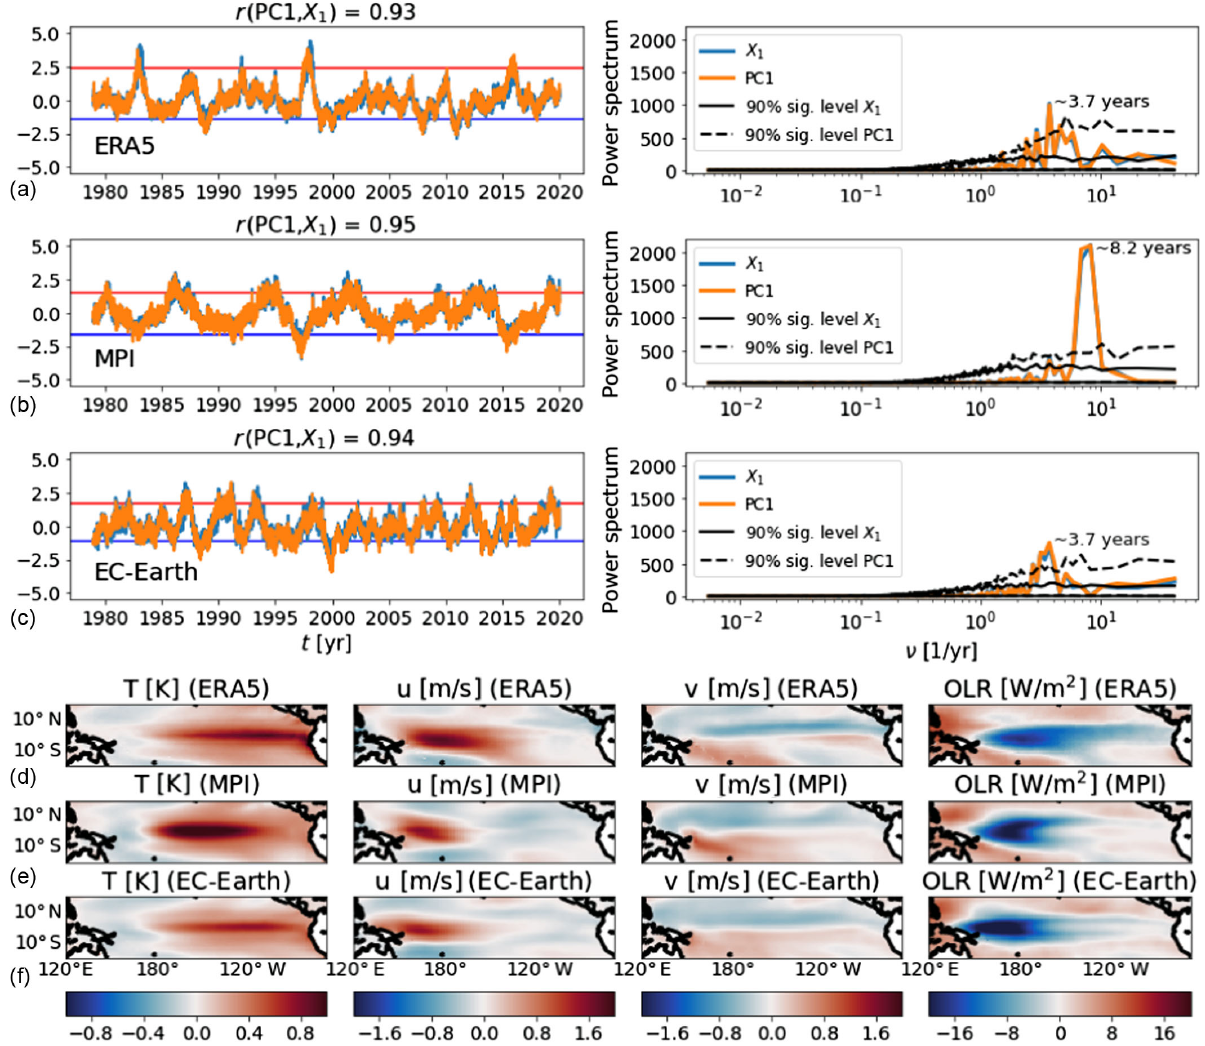
FIG. 15. (a) – (c), left-hand column: first (standardized) Isomap ( X 1 ) and principal component (PC1) for observations (ERA5) and the two CMIP6 models (MPI and EC-Earth). Red (blue) lines represent the median of positive (negative) values in the 0.1 quantile (10th percentile) of the joint PDF of d and θ (see Fig. 5). Right-hand column: correspondent Fourier spectra. The spectral significance has been tested under the null hypothesis of red noise [96 – 98]. (d) – (f) Projection of the first (embedded) Isomap component on the various